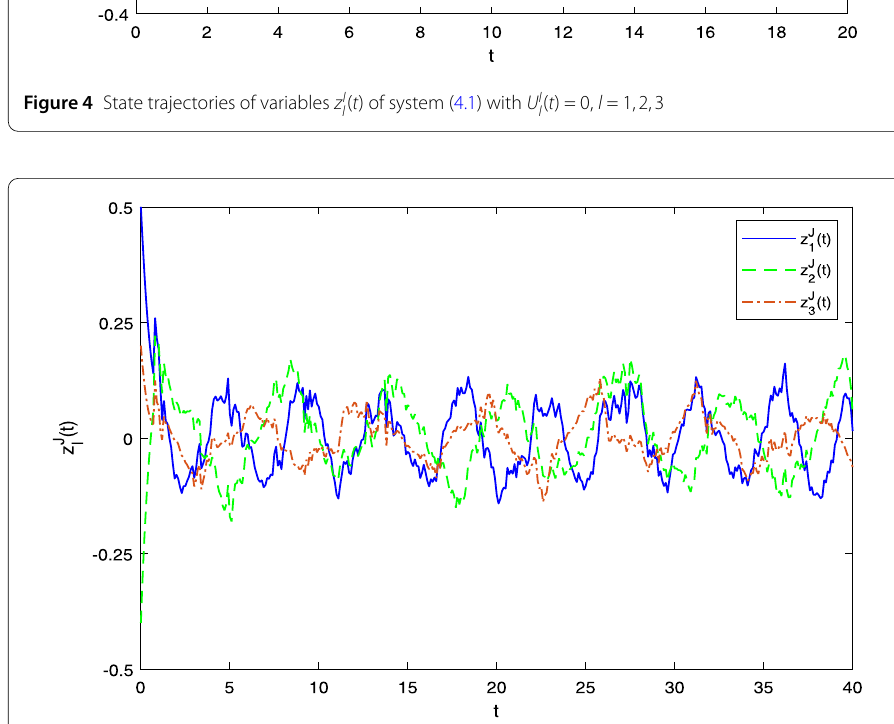
Figure 5 State trajectories of variables z J